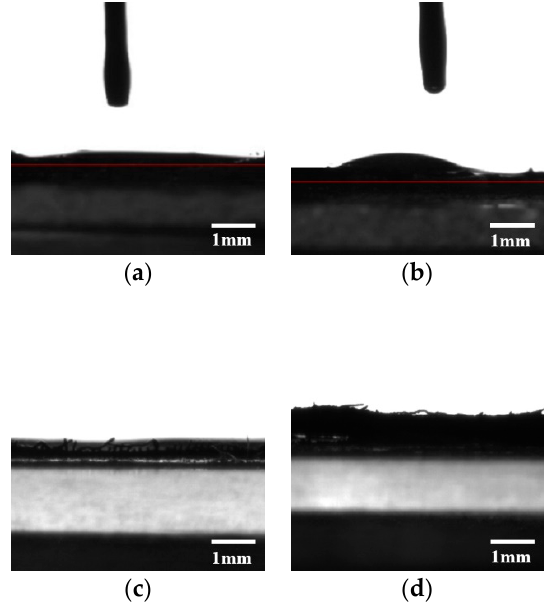
Figure 8. Wettability of the surfaces of the mesh membranes; oil droplets on: ( a , c ) parabolic morphology; ( b , d ) truncated cone morphology.